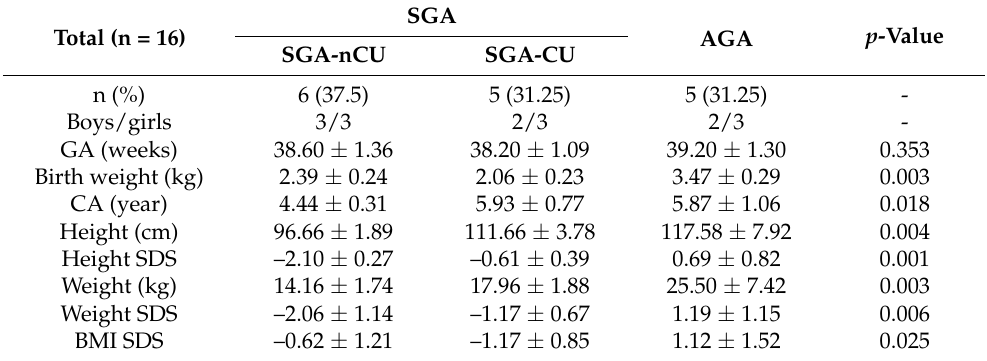
Table 2. Clinical characteristics of SGA and control cases who underwent miRNA analysis using